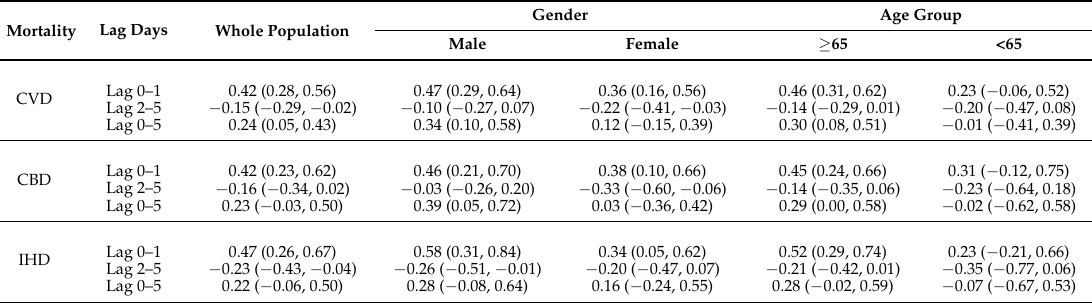
Table 2. Estimated percent increase (95% CI) in risk of death associated with per 10 µ g/m 3 increase in PM 2.5 by death causes in whole and subgroup population in Beijing, China (2008–2011) *.